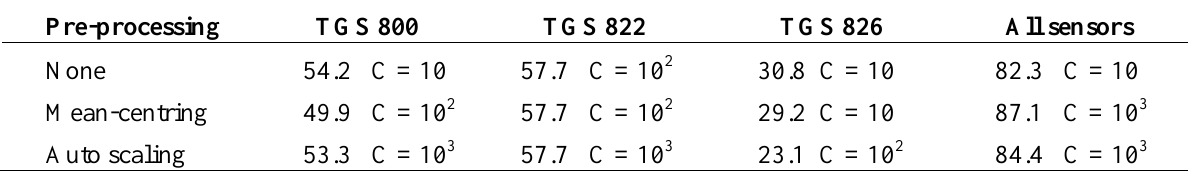
Table 1 . Success rate in vapour identification (%) using the steady state sensor response. Validation results are reported. The optimal value of parameter C is also shown.